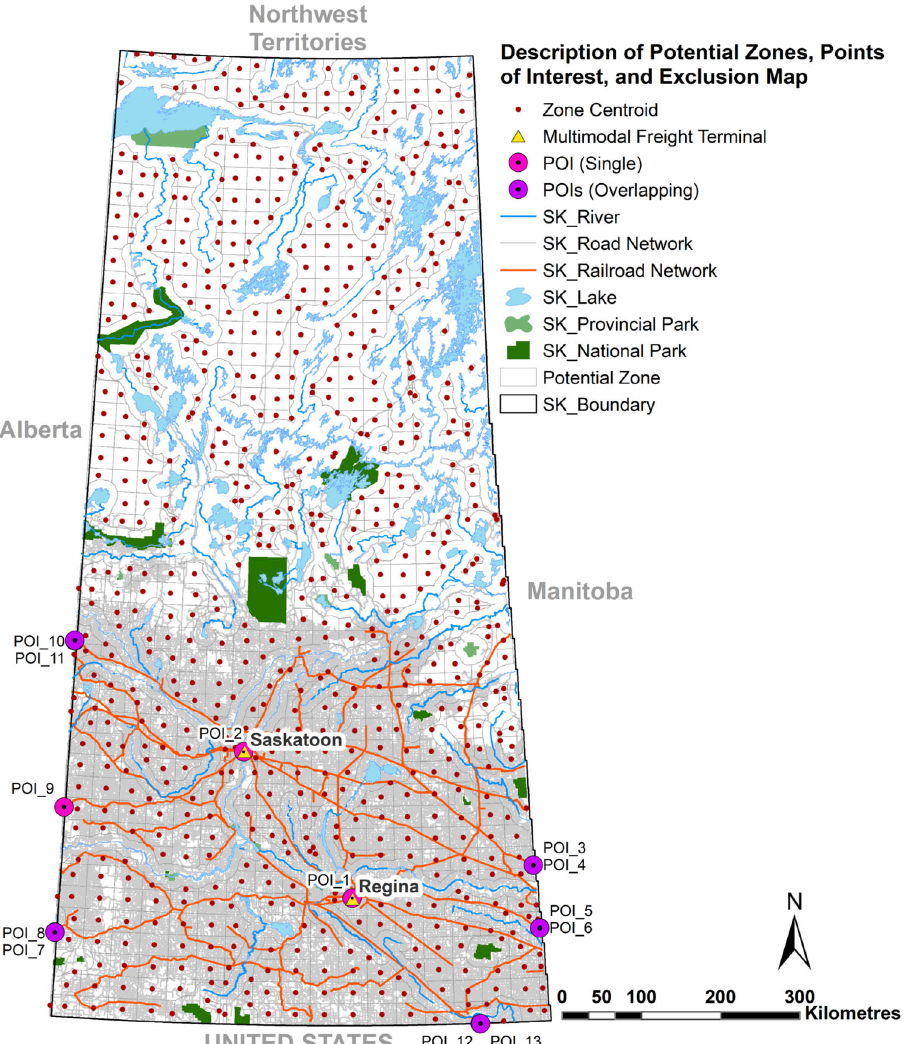
Fig. 2 Road network, potential zones, points of interest, and exclusion